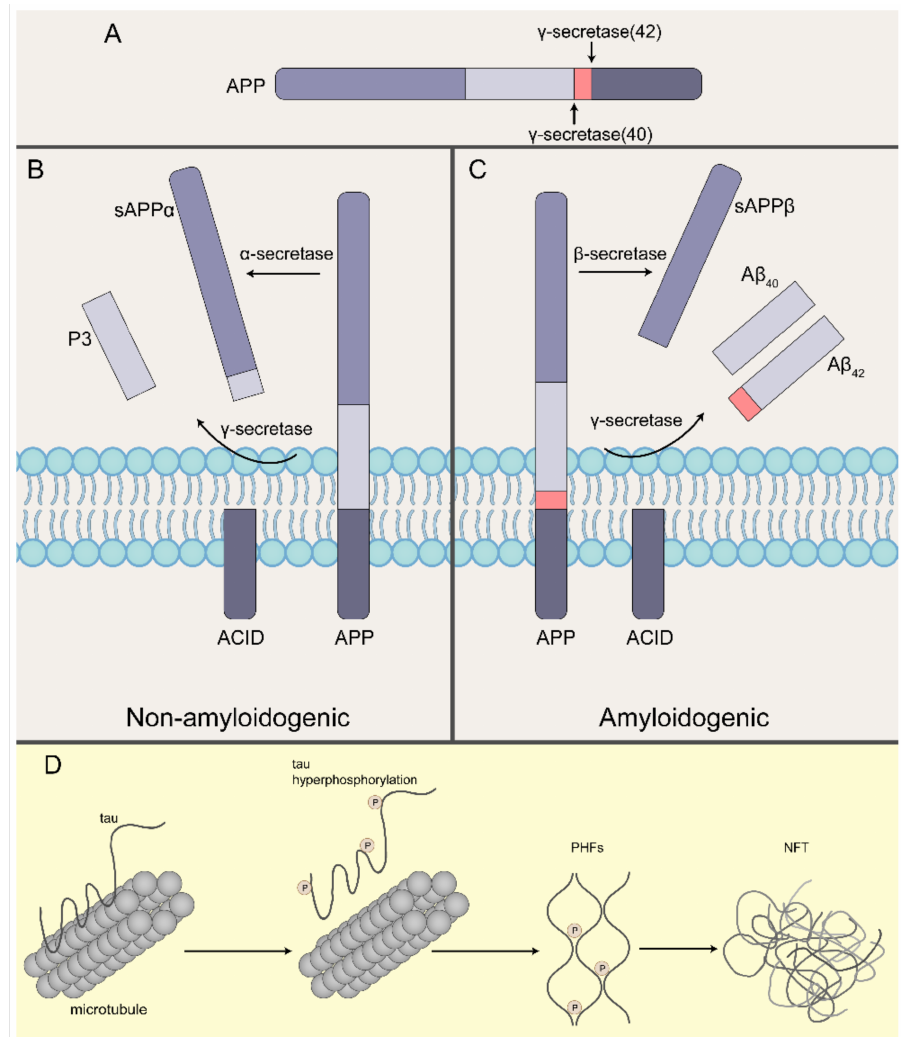
Figure 1. Pathological A β and tau formation in Alzheimer’s disease. ( A ) Cleavage sites for γ